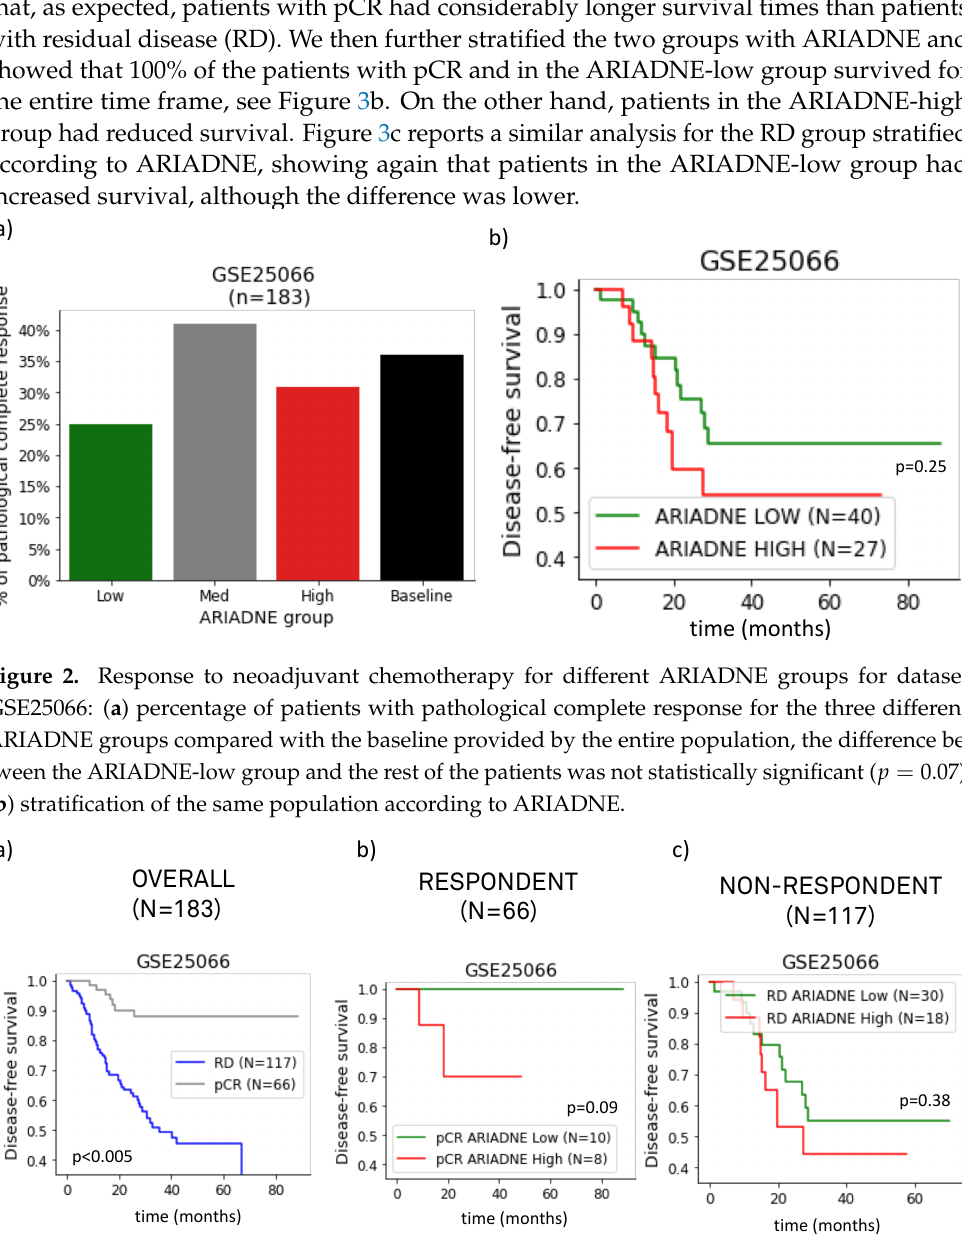
Figure 3. Survival curves of TNBC patients depending on their response to neoadjuvant chemother- apy for dataset GSE25066: ( a ) patients that responded to chemotherapy (pCR) had longer survival than those with residual disease (RD); ( b ) survival curves showing that among the patients with pathological complete response all those belonging to the low risk group according to ARIADNE survived for the considered time period, while survival was reduced for those belonging to the high-risk group; ( c ) the difference in survival among ARIADNE groups was smaller for patients that did not